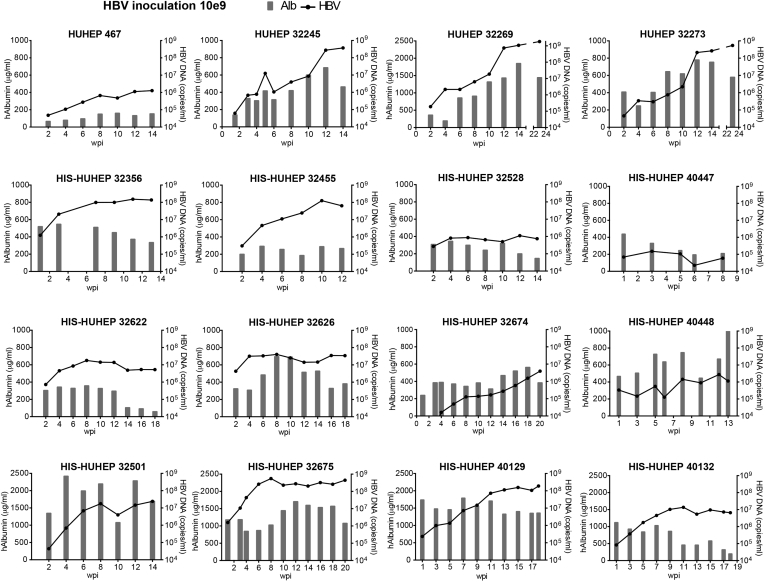
Longitudinal follow-up of HBV viremia (black line) and hAlbumin (grey bars) in the plasma of individual HUHEP and HIS-HUHEP mice inoculated with high-dose HBV 10e9.